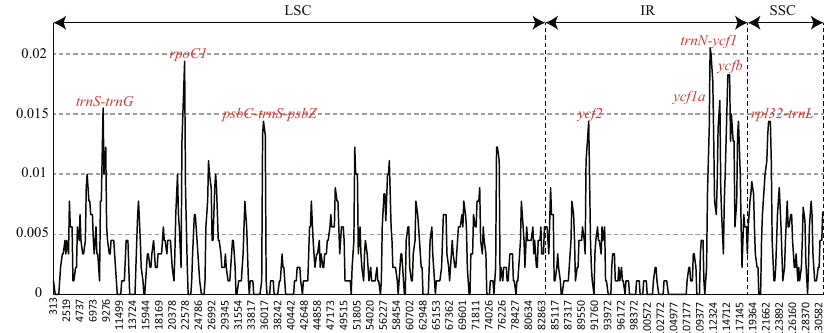
Figure 3. Sliding window analysis of the whole chloroplast genome of three Paris species. (window length: 600 bp, step size: 200 bp). X-axis: position of the midpoint of a window, Y-axis: nucleotide diversity of each window.